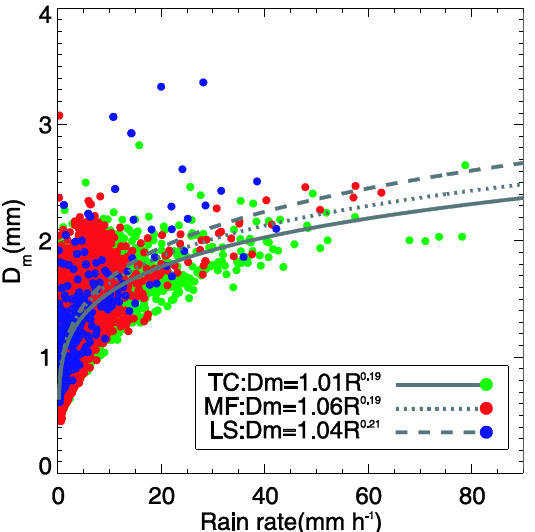
Figure 7. D m versus rain rate for the three rain types from the JWD data along with the best fit lines using the least squares method. The exponent values of the D m – R relationship obtained from the curve estimation by SPSS software with significance level <0.05.